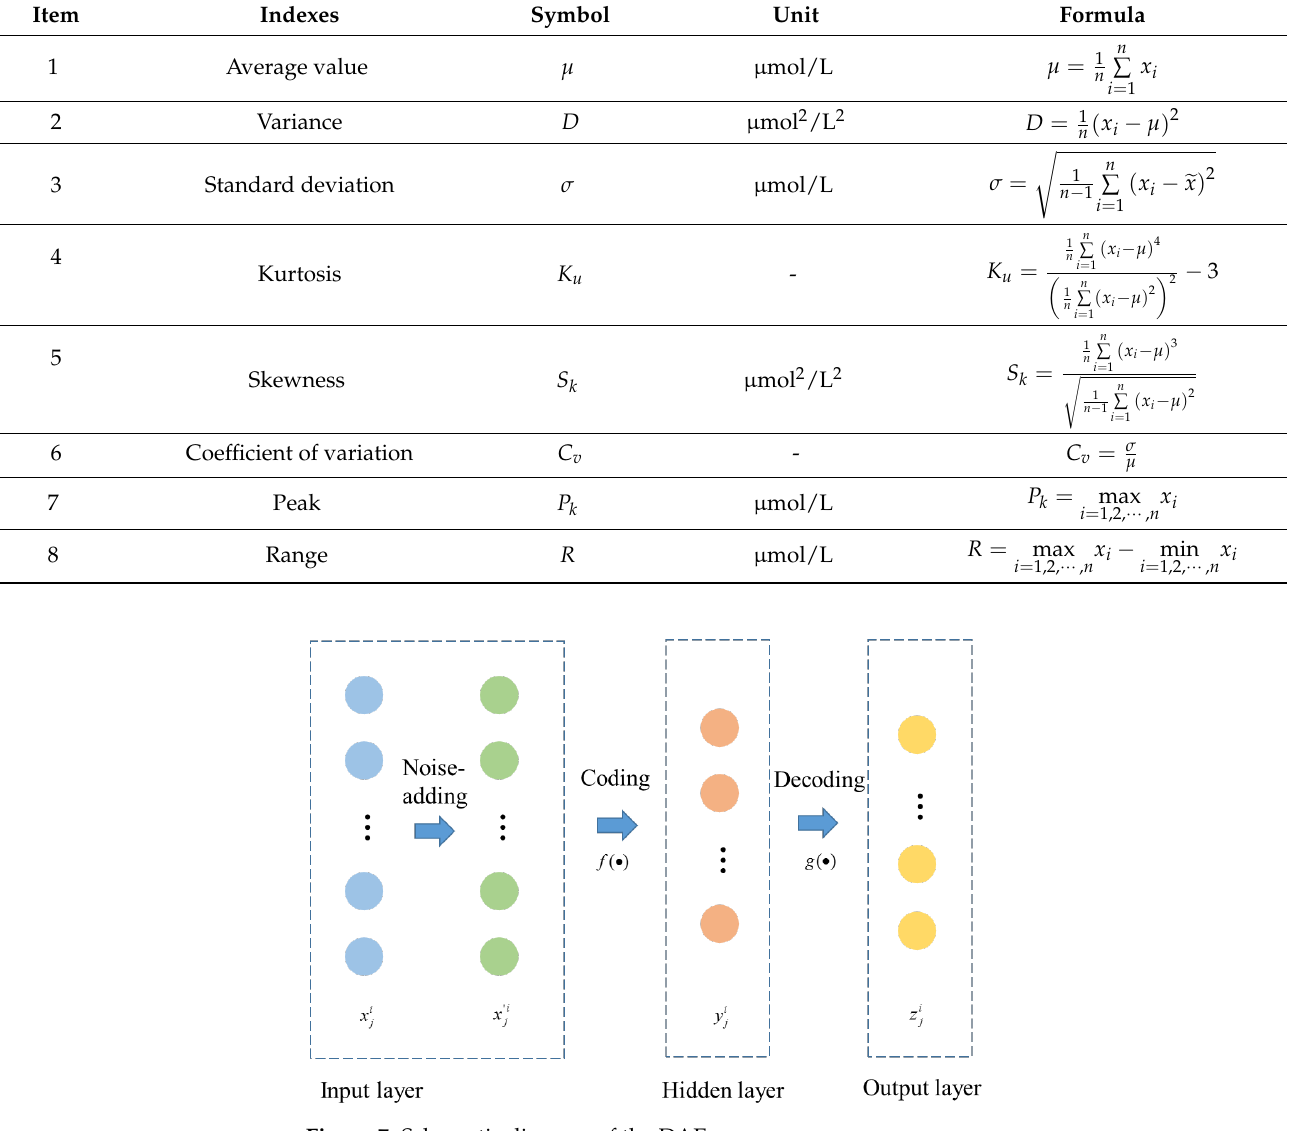
Figure 7. Schematic diagram of the DAE.